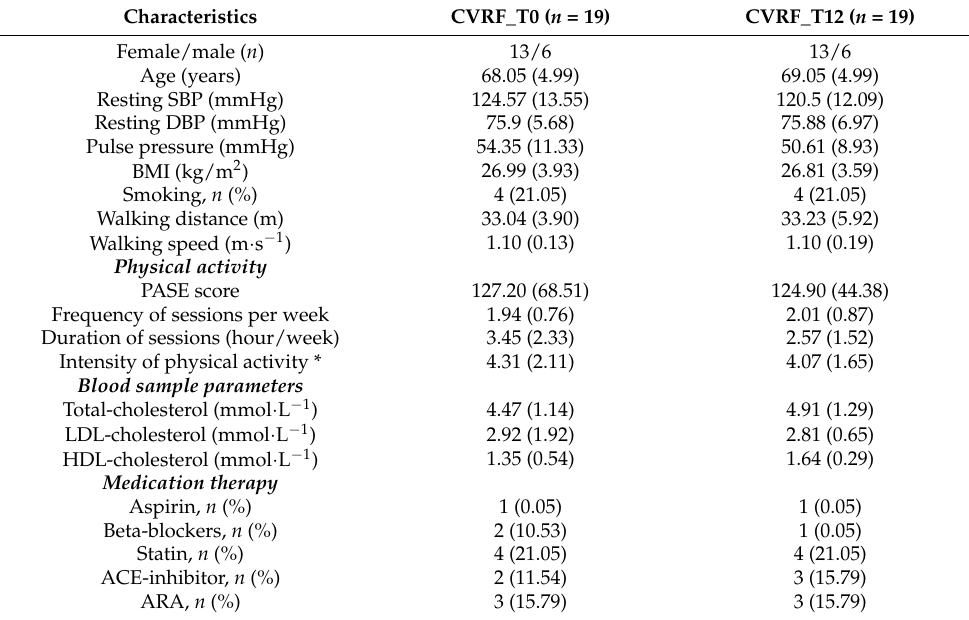
Table 1. Summary of demographic characteristics of the